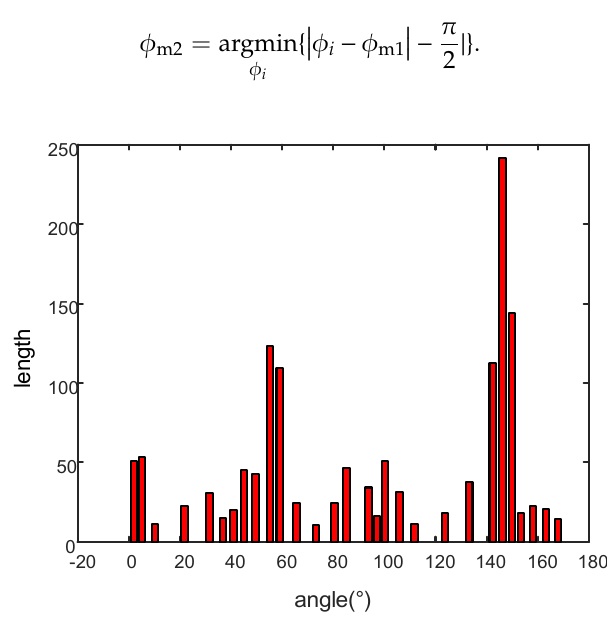
Figure 9. The result of room dominant direction detection.